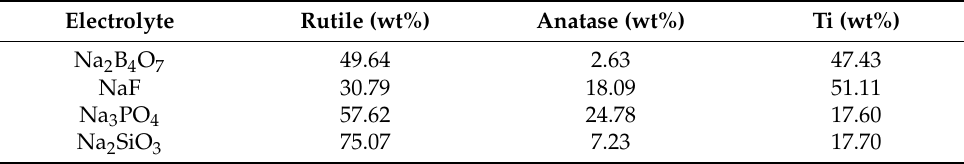
Figure 7. XRD diffractograms of the coating obtained by performing the MAO treatment for 12,000 s using the four electrolytes. Table 2. Phase content of the coating obtained at 12,000 s in the four electrolytes.